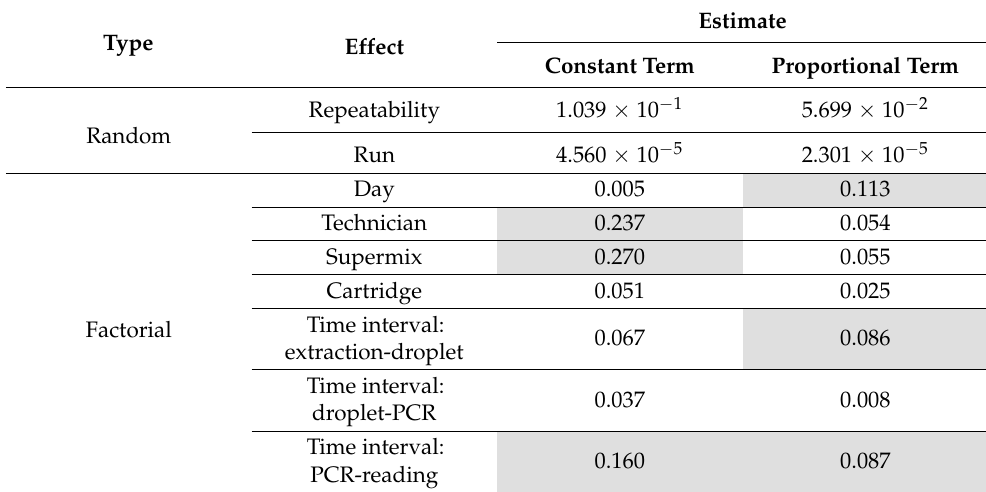
Table 8. Absolute value of parameter effects. Significant effects (5%) are highlighted.